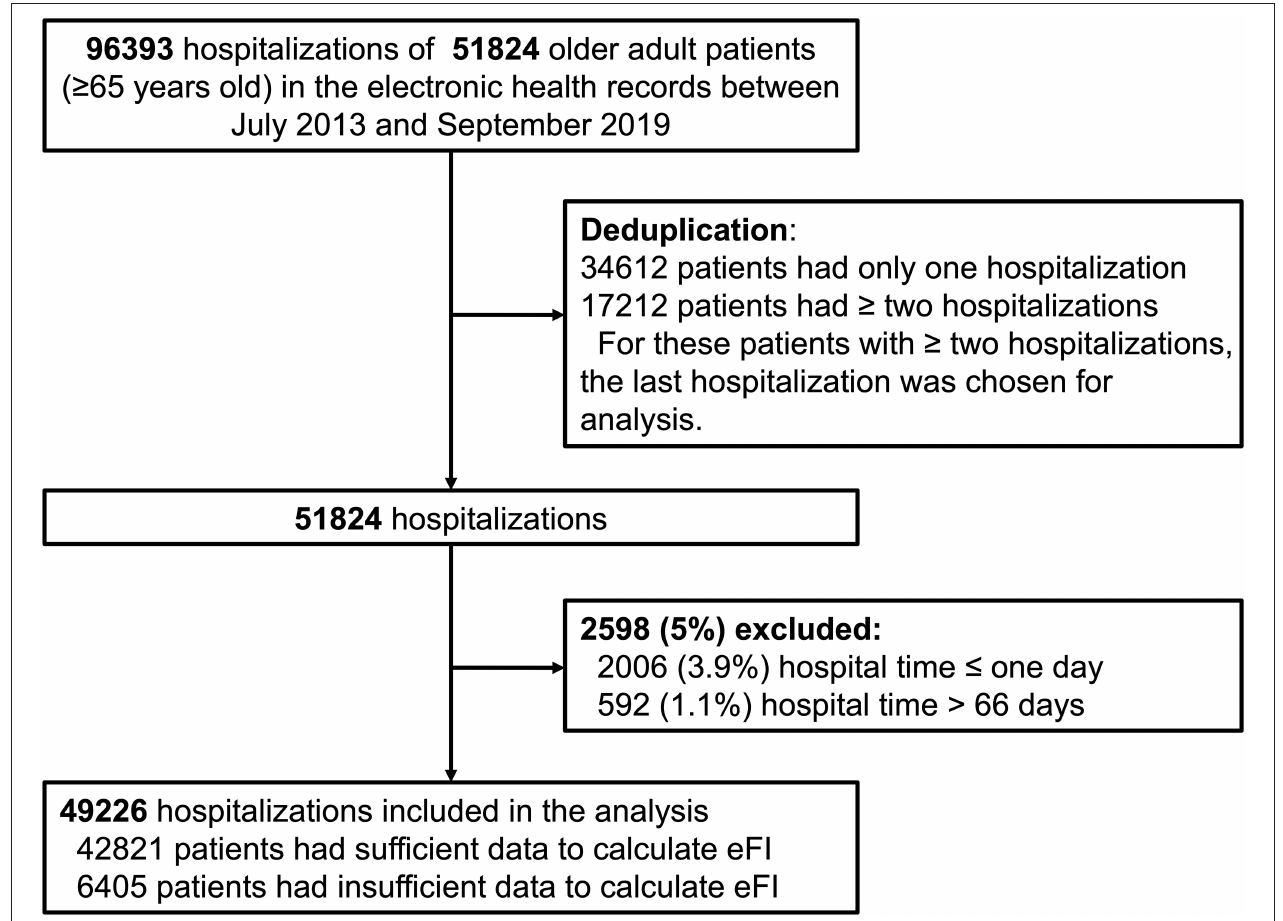
FIGURE 1 | Flow chart of the study